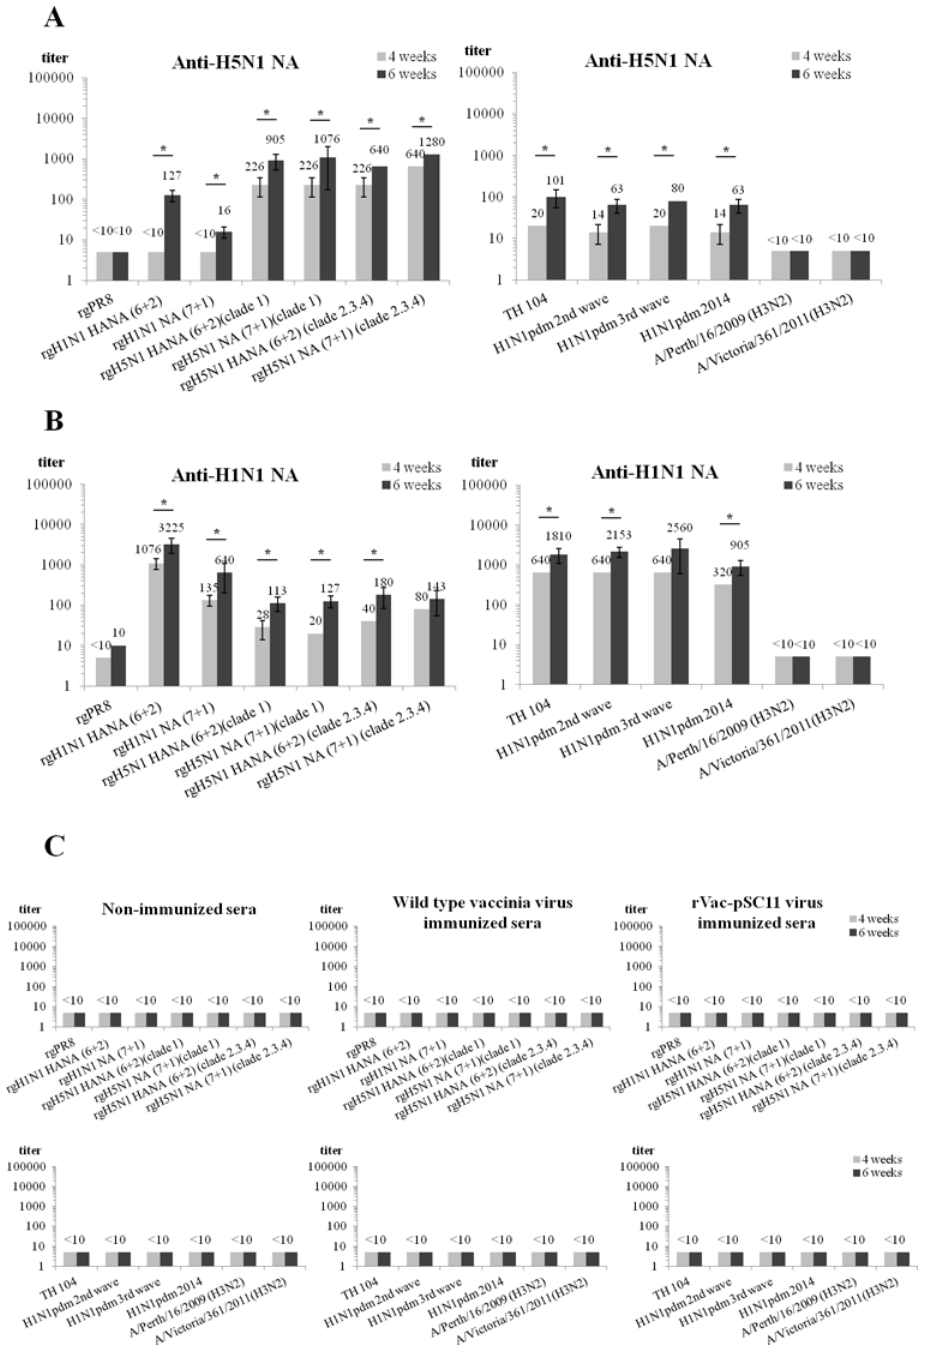
Fig 6. NI antibodies in sera of mice immunized with recombinant vaccinia virus harboring H5N1 NA gene (anti-H5N1 NA) or H1N1 NA gene (anti-H1N1 NA) as assayed against reverse genetic (rg) viruses (left column) and wild type influenza viruses (right column) determined by ELLA. (A) Anti-H5N1 NA antisera react with rg viruses containing homologous clade 1 NA gene and cross react with rg viruses containing clade 2.3.4 NA and H1N1 wild type viruses from various epidemic waves. No cross reaction is observed with rgPR8 (H1N1) virus and H3N2 wild type viruses. (B) Similar results are obtained with anti- H1N1 NA antisera. Mouse immune sera collected at 6 weeks p.i. showed significantly higher NI antibody titers than those collected at 4 weeks p.i. for the tested viruses with asterisk (Mann-Whitney U test, p < 0.05). (C) Normal mouse sera, sera from mice immunized with wild type vaccinia virus or rVac-pSC11 virus did